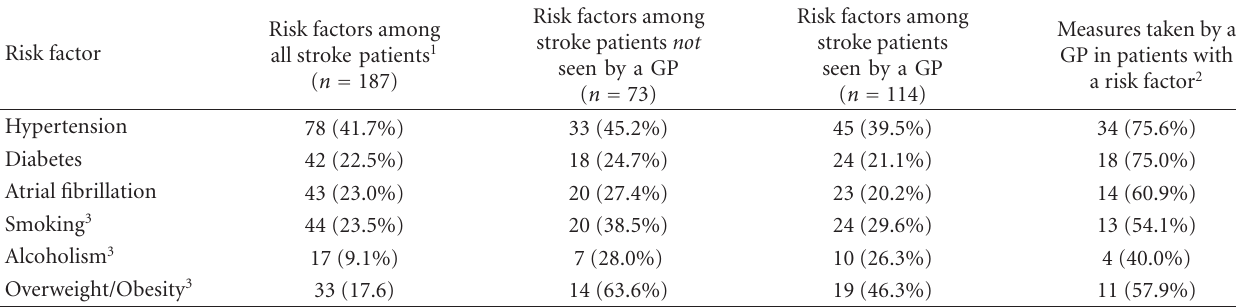
Table 1: Known risk factors among 187 stroke patients and measures taken in primary health care for the 114 patients who had seen a general practitioner (GP) in the year preceding their stroke, in numbers and